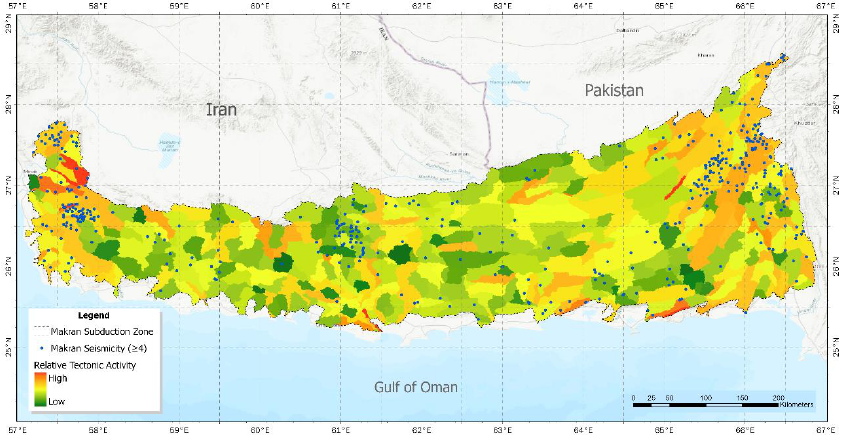
Figure 7. The result of applying the best method for whole watersheds in Makran subduction zone.